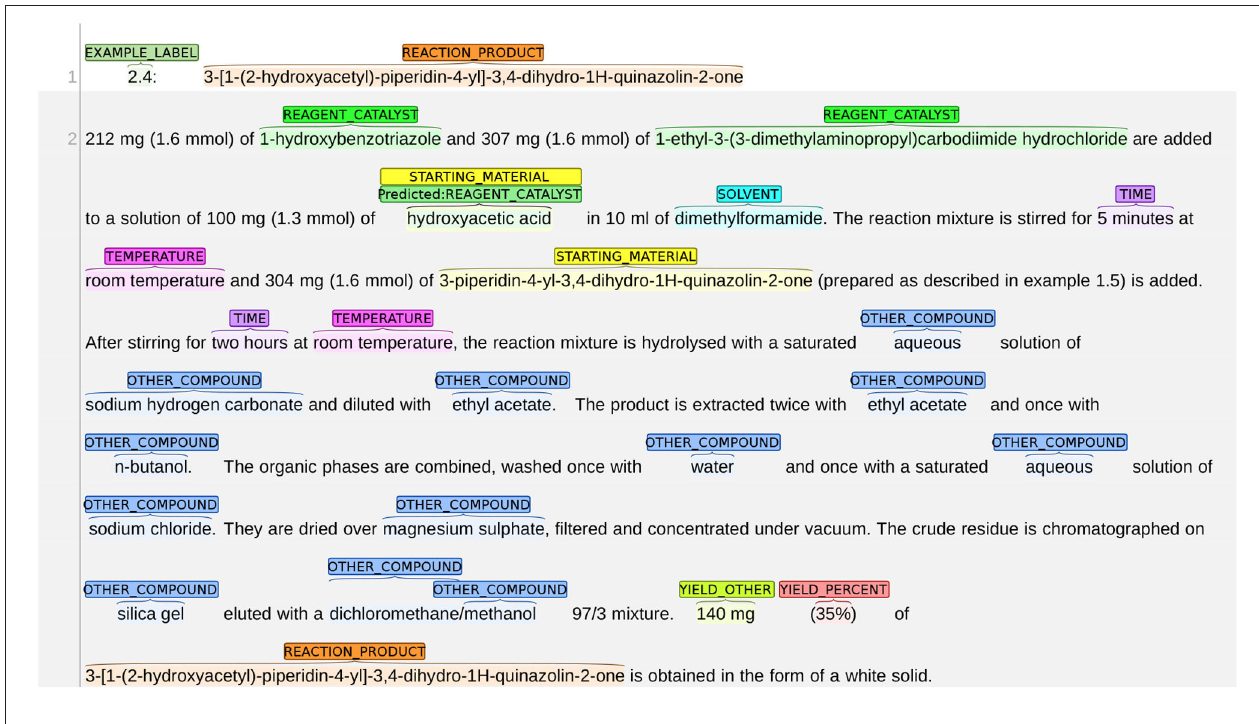
FIGURE 9 | An example of the system misclassifying STARTING_MATERIAL as REAGENT_CATALYST.